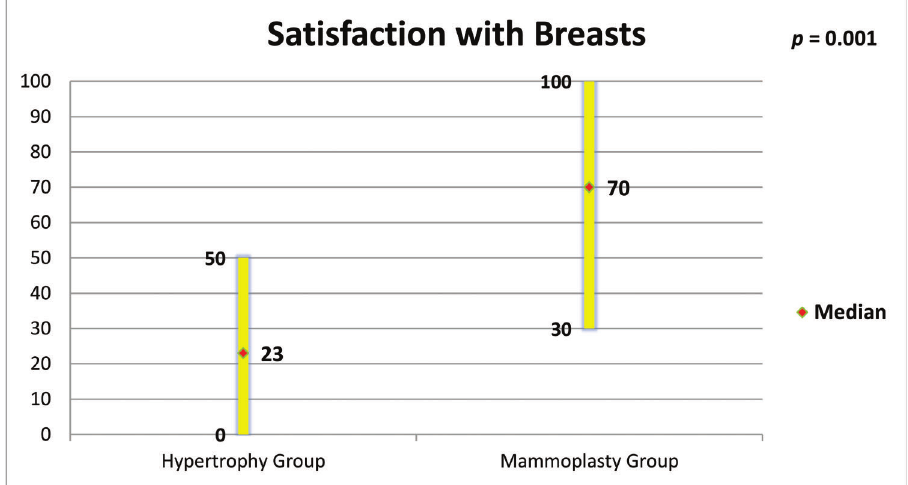
Figure 5 - Scores of BREAST-Q s subscale ‘‘ Satisfaction with breasts ’’ in both groups and comparison by the Mann-Whitney